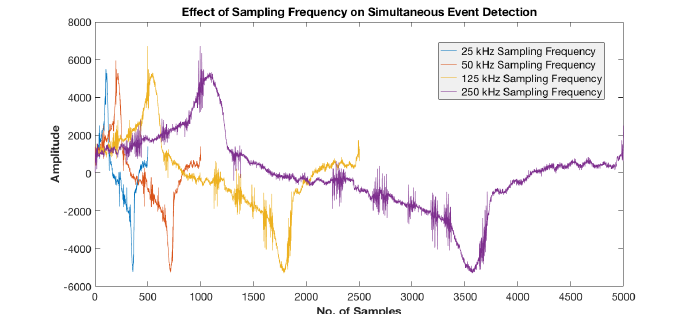
Figure 13. Current waveform acquired at 250 kHz using CLEAR [57] and downsampled at different sampling